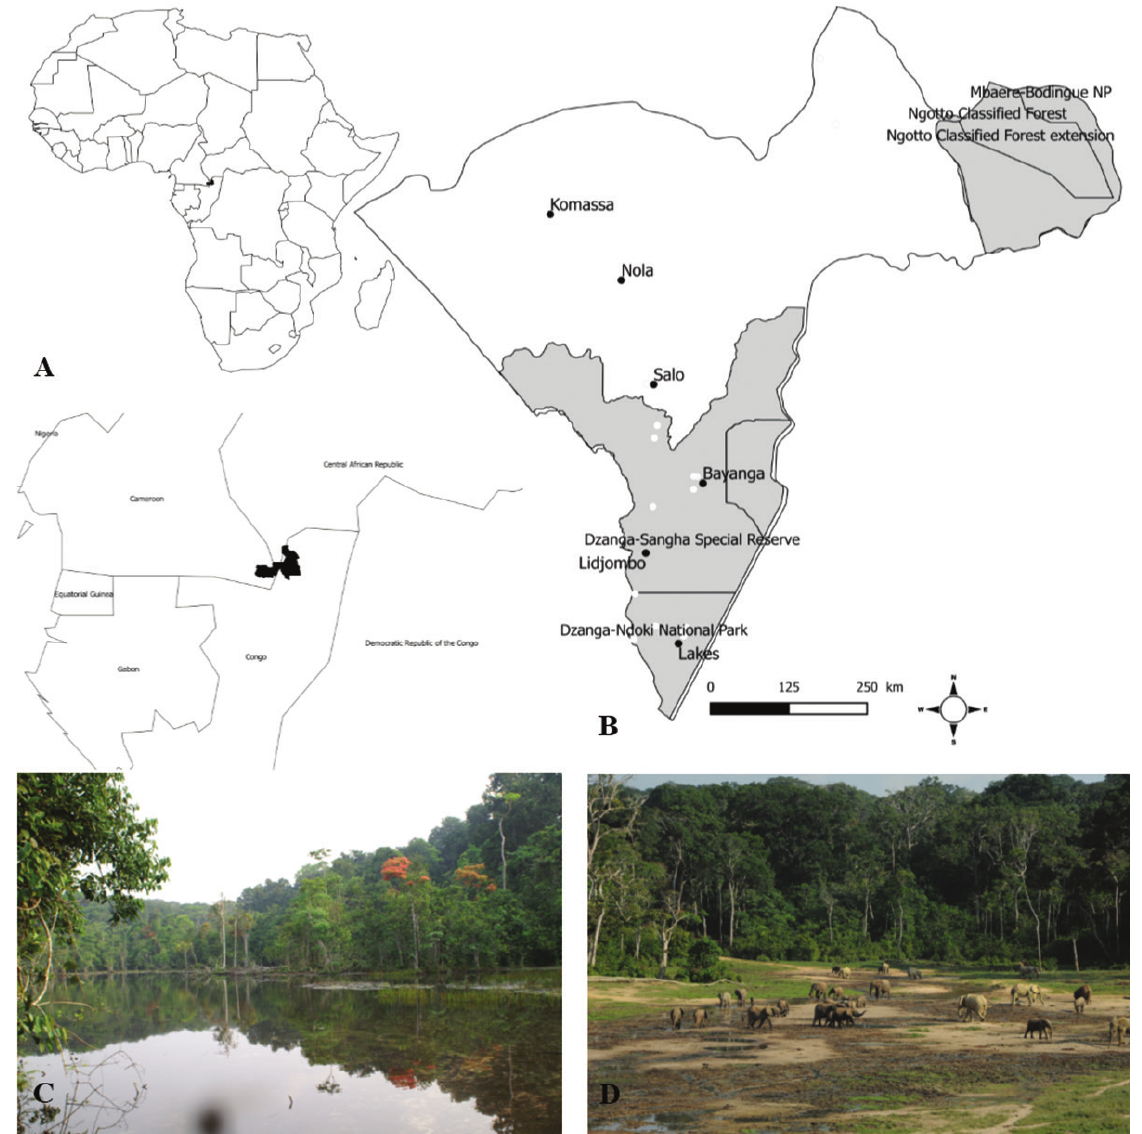
Fig. 1. Sangha-Mbaere Region in Central African Republic. A. Location of Tri National Sangha area in Central Africa; B. Location of principal sampling stations and largest towns. Black dots: Main city in Sangha-Mbaere Region. White dots: Main collection areas. Sources: http://www.diva-gis.org adminstrative area, Sangha-Mbaere Region; C. Illustration of the habitats studied; D. Primary forest of CAR, Dzanga Bai with forest